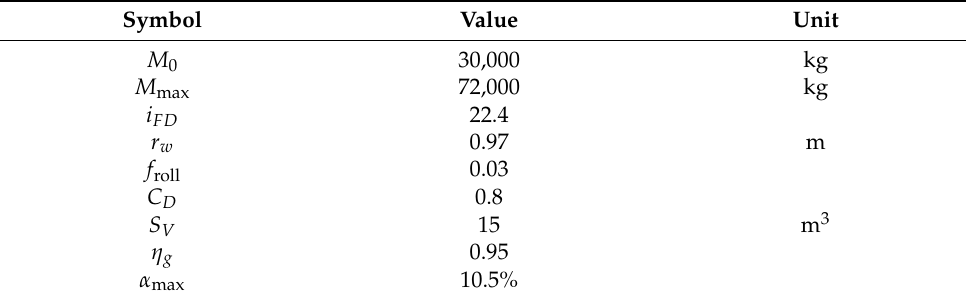
Table 2. Simulation parameters.